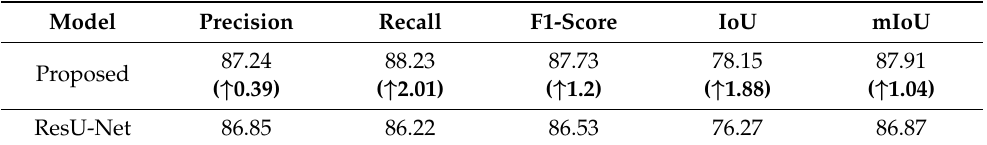
Table 4. Performance of models on the Iburi dataset. The bold means the variation between the proposed model and ResU-Net. Model Precision Recall F1-Score IoU mIoU 77.09 81.70 Proposed ResU-Net